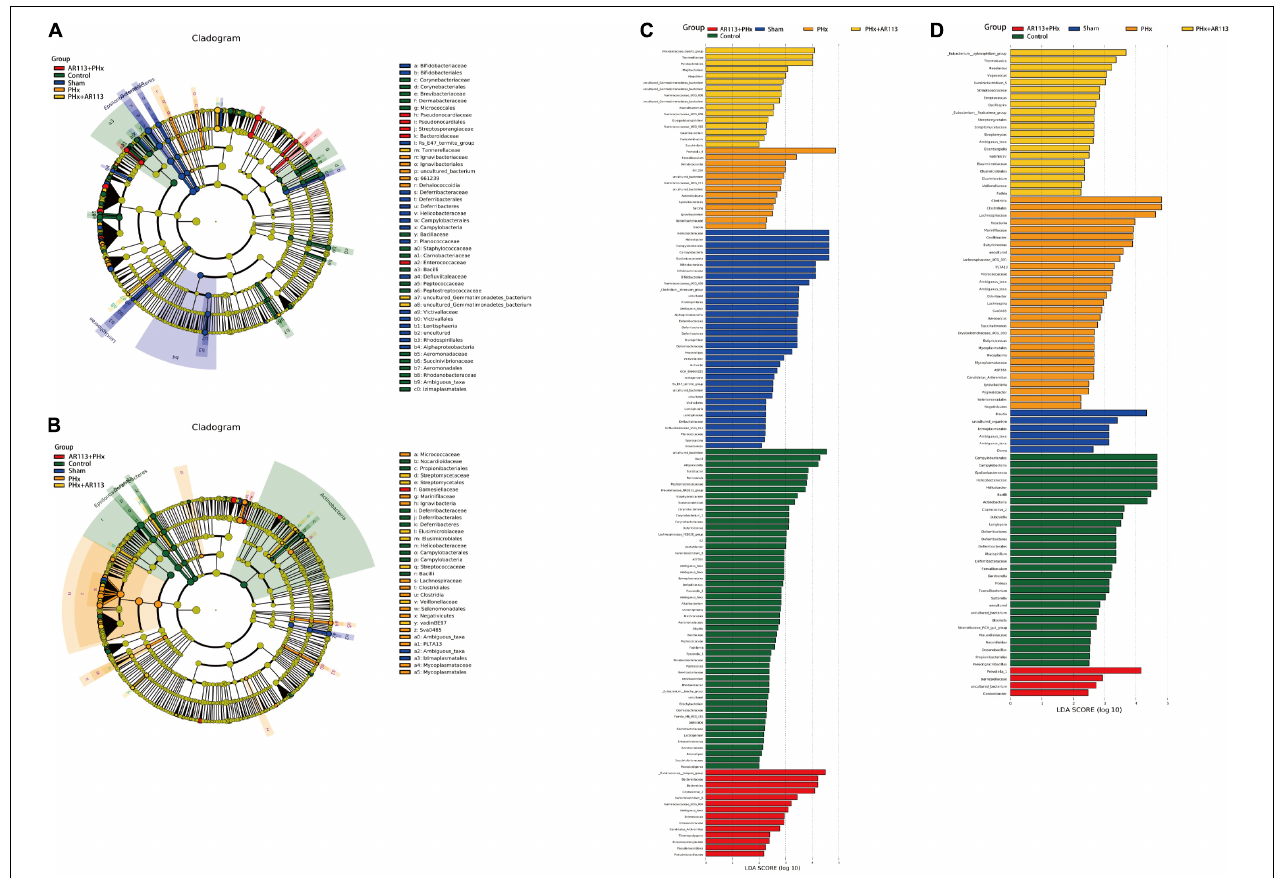
FIGURE 7 | LEfSe analysis among the Control, Sham, PHx, AR113+PHx, and PHx+AR113 groups. Cladogram displays the taxonomic tree of differentially abundant taxa. Histograms represent the LDA scores of bacteria with significant differential abundance between the compared groups, identified by different colors. Features with LDA score ≥ 3. (A,C) , 3 days after PHx. (B,D) , 7 days after PHx.